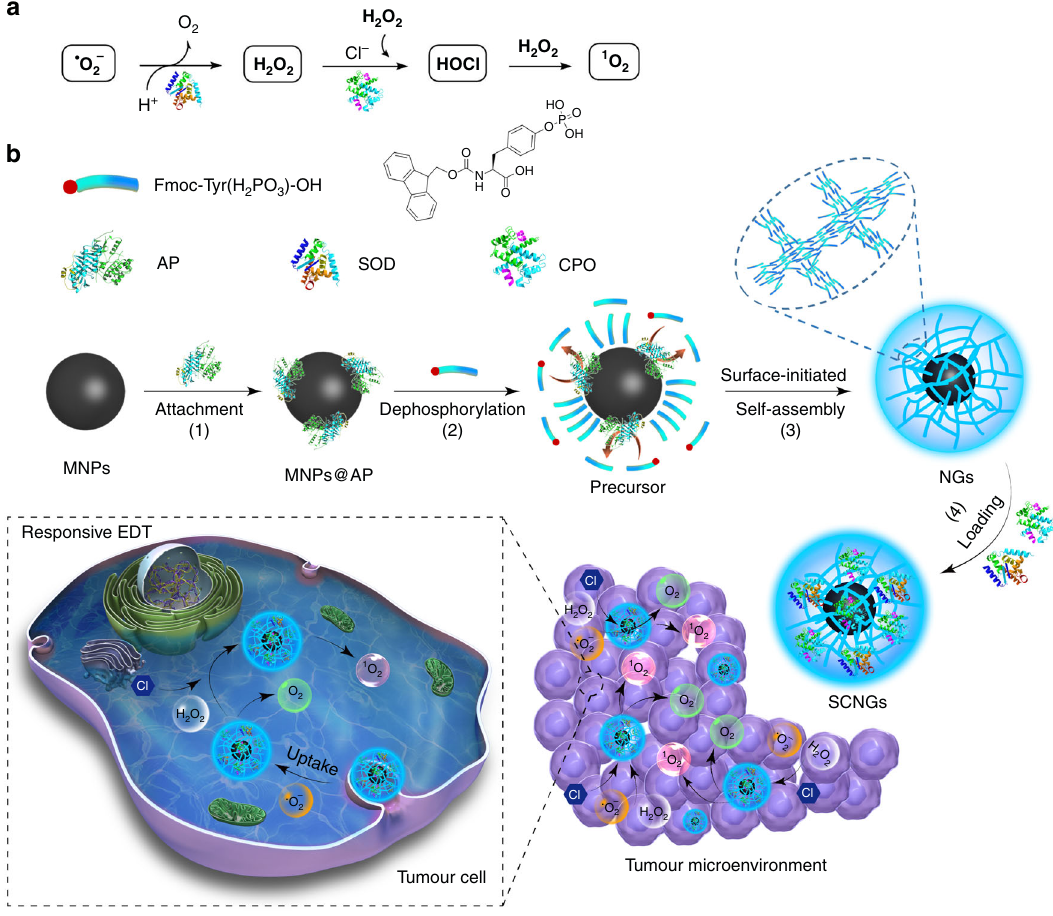
Fig. 1 Scheme of the responsive EDT mechanism and preparation of SCNGs. a The cascade SOD/CPO-mediated therapy includes the catalysis of ˙ O 2 ˉ into H 2 O 2 by SOD, conversion of both as-obtained H 2 O 2 and endogenous H 2 O 2 species into fi nal 1 O 2 species with CPO. b The fabrication process of SCNGs involves (1) modi fi cation of MNPs core and the AP trigger attachment, (2) dephosphorylation of hydrophilic peptide precursors to hydrophobic hydrogelators by the bounded AP, (3) AP-triggered self-assembling between the hydrophobic portions and hydrophilic part of hydrogelators through π – π stacking and electrostatic interactions around MNP, (4) immobilization of cascade SOD and CPO and further a safe and effective EDT in tumour microenvironment. The responsive SCNGs can effectively convert the endogenous ROS ( ˙ O 2 ˉ and H 2 O 2 ) into highly reactive 1 O 2 by the cascade reaction of SOD and CPO in tumour region, which subsequently cause cancer cells